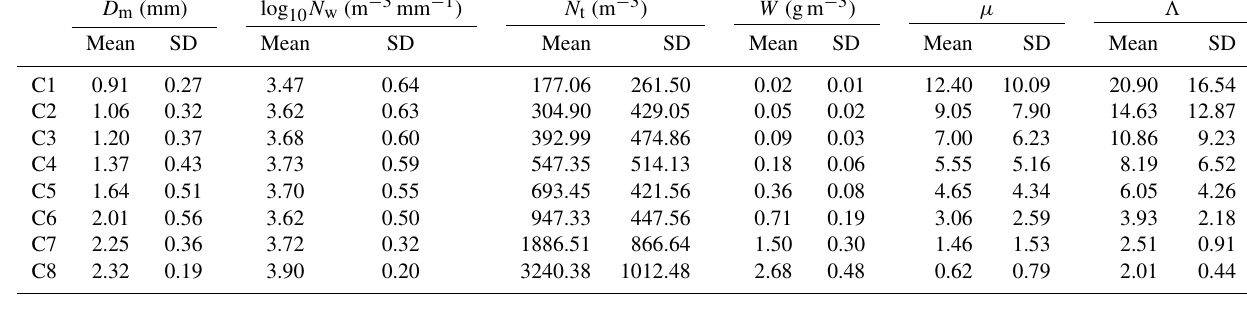
Table 4. Number and DSD retrieved rain rate statistics of each rain rate class.